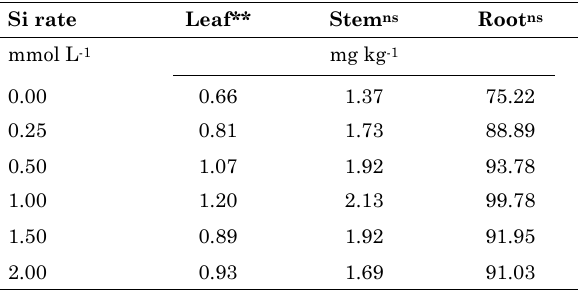
Table 2. Arsenic content in leaves, stems, and roots of maize plants grown in nutrient solutions with Si Si